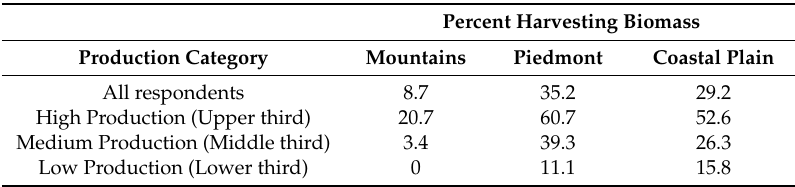
Table 5. Percent of businesses indicating harvest of biomass/fuel chips by region across production category when sorted by production level.